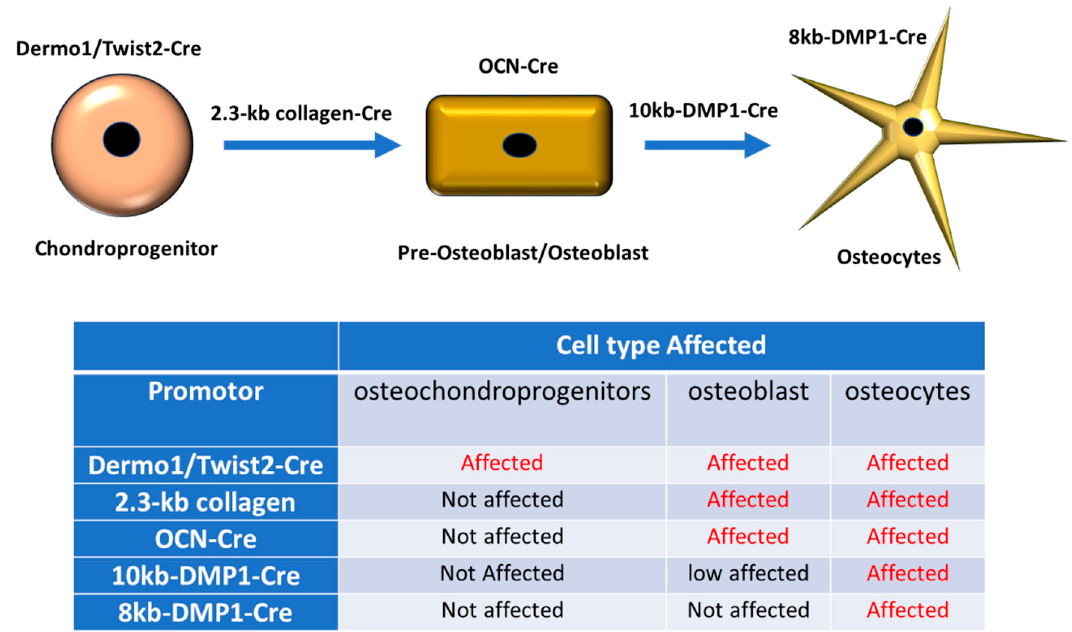
Figure 1. Schematic representation of sequential activation of bone master gene promoters used for Cre expression or gene overexpression. During bone development there is a successive expression of master genes that provide the special characteristics of bone cells. For example, chondroprogenitor cells express the Dermo1/Twist2 promotor, if fused with Cre protein and expressed in the cell, flox-tagged genes will be removed and the complete cell linage will be affected. However, if Cre is controlled by a late gene such as DMP1, which is mainly expressed in osteocytes, flox-tagged genes will be primarily removed in osteocytes and not preceding cell lineage types, such as the osteoblasts. The promoters mentioned in this review and the differentiation state for their activation are summarized in the table below.